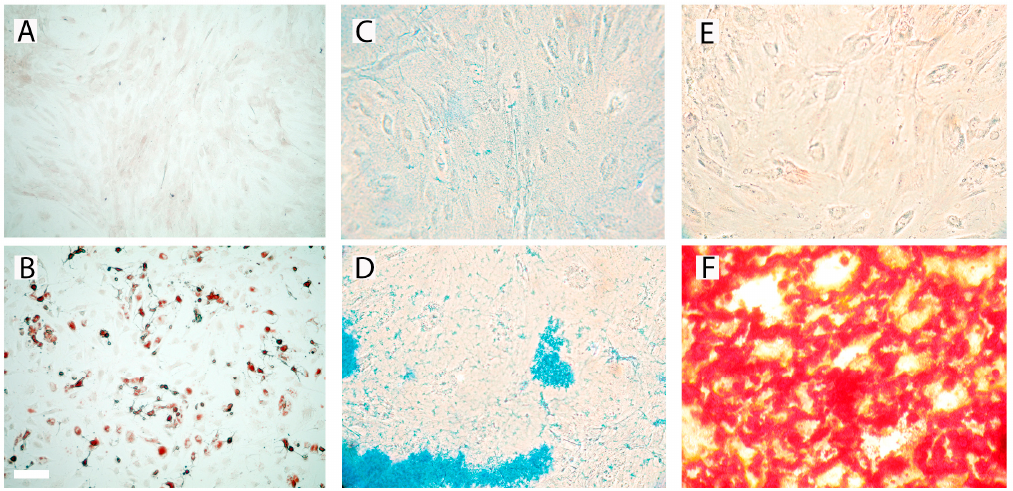
Figure 2. Trilineage differentiation of cultured prASCs. Differentiation into adipocytes, chondrocytes and osteoblasts was induced by adipogenic ( B ), chondrogenic ( D ) and osteogenic ( F ) medium for 14 days. Control cells were cultured in standard culture medium for 14 days ( A , C , E ) After 14 days of incubation in either standard or differentiation medium, cultures were stained with Oil Red O ( A , B ), Alcian Blue 8GX ( C , D ) or Alizarin Red S ( E , F ) (bar: 100 µm). In addition to their trilineage differentiation potential, prASCs were also able to differentiate into the epithelial lineage. In order to elucidate the influence of ATRA on prASCs differentiation, expression of CK-18, an early epithelial marker, was evaluated by qPCR analysis (Figure 3A), immunofluorescence staining (Figure 3B) and Western blotting (Figure 3C,D). After incubation with ATRA for 14 days, the expression of CK-18 mRNA was 6.2-fold induced compared to unstimulated control cells (Figure 3A). Immunofluorescence staining revealed that approximately 45% of the cells were CK-18 positive (Figure 3B), and Western blot analysis also clearly showed the significant induction of CK-18 protein in epithelial-induced prASCs (Figure 3C) (densitometric analysis calculated in percent: control (standard medium) = 100% (background signal); ATRA = 286% (Figure